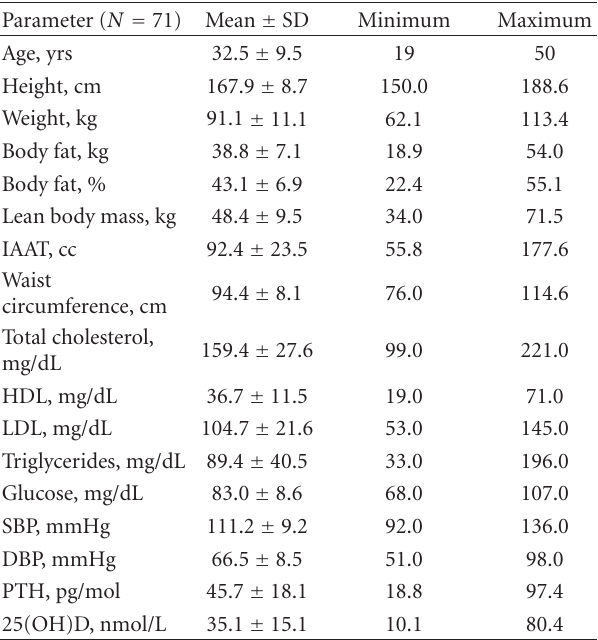
Table 2: Physical characteristics of subjects at run-in.